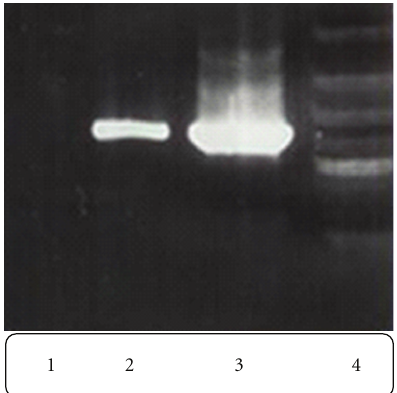
Figure 4: Gel-electrophoresis analysis of PCR products performed on stable transfected CHO cells and control cell line. Lane 1: PCR product from nontransfected CHO genomic DNA. Lane 2: PCR product from transfected CHO genomic DNA. Lane 3: PCR product from another transfected CHO genomic DNA. Lane 4: 1kb ladder